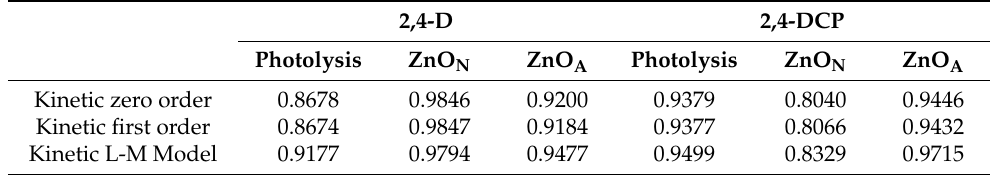
Table 5. Coefficient of correlation of kinetic Equation.